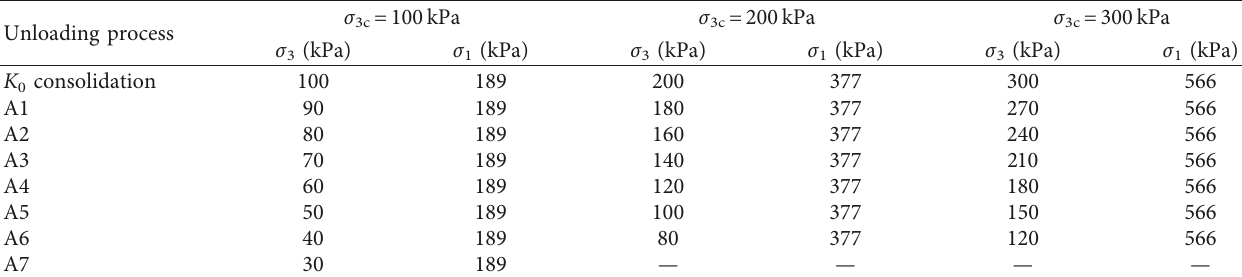
Table 2: The test unloading schemes.